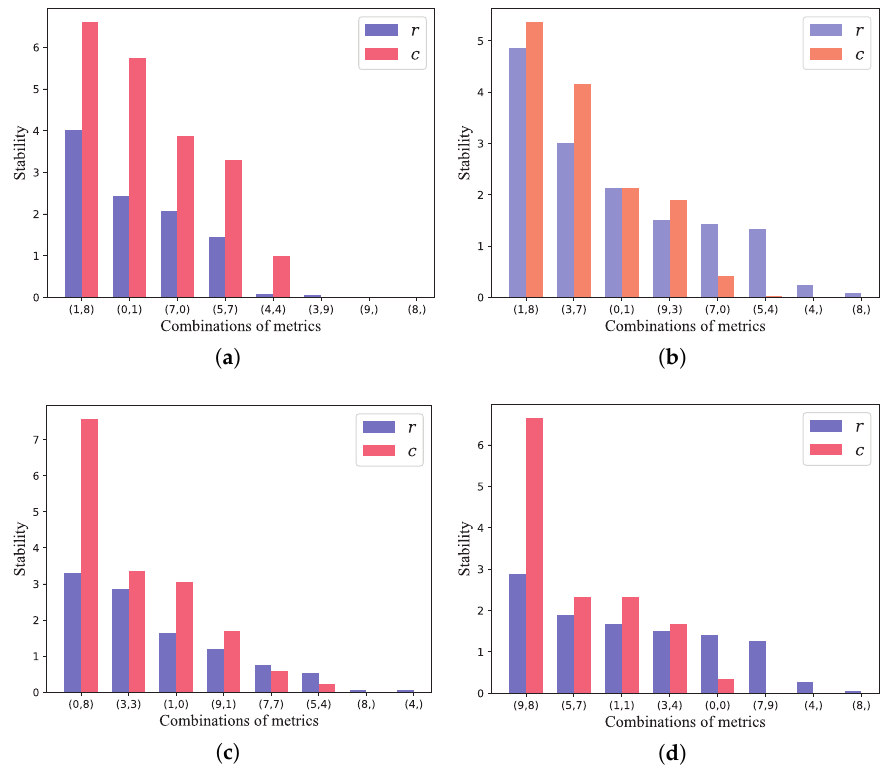
Figure 7. The most stable metric combinations for recall. ( a ) State. ( b ) Tri-state. ( c ) IFS-tri-state. ( d )